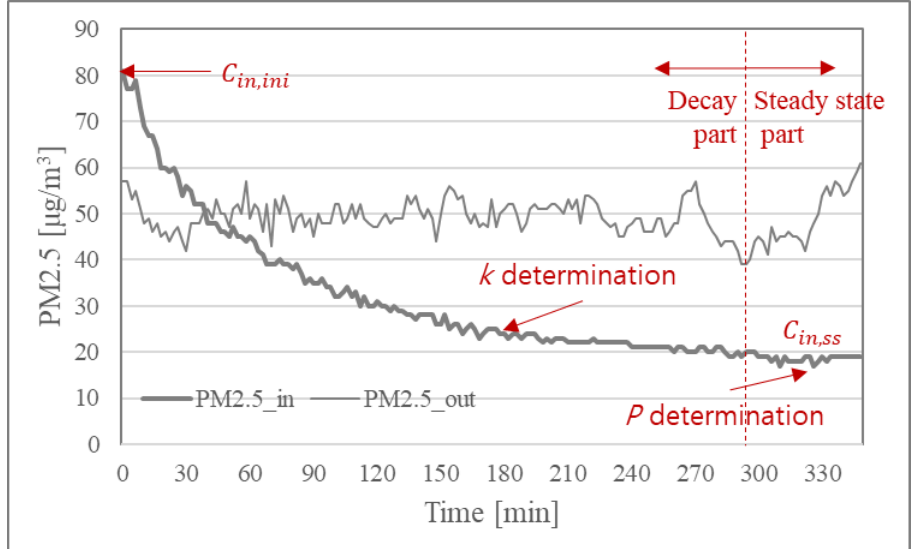
Figure 4. An example of indoor and outdoor PM2.5 concentration for estimating parameter P and k.